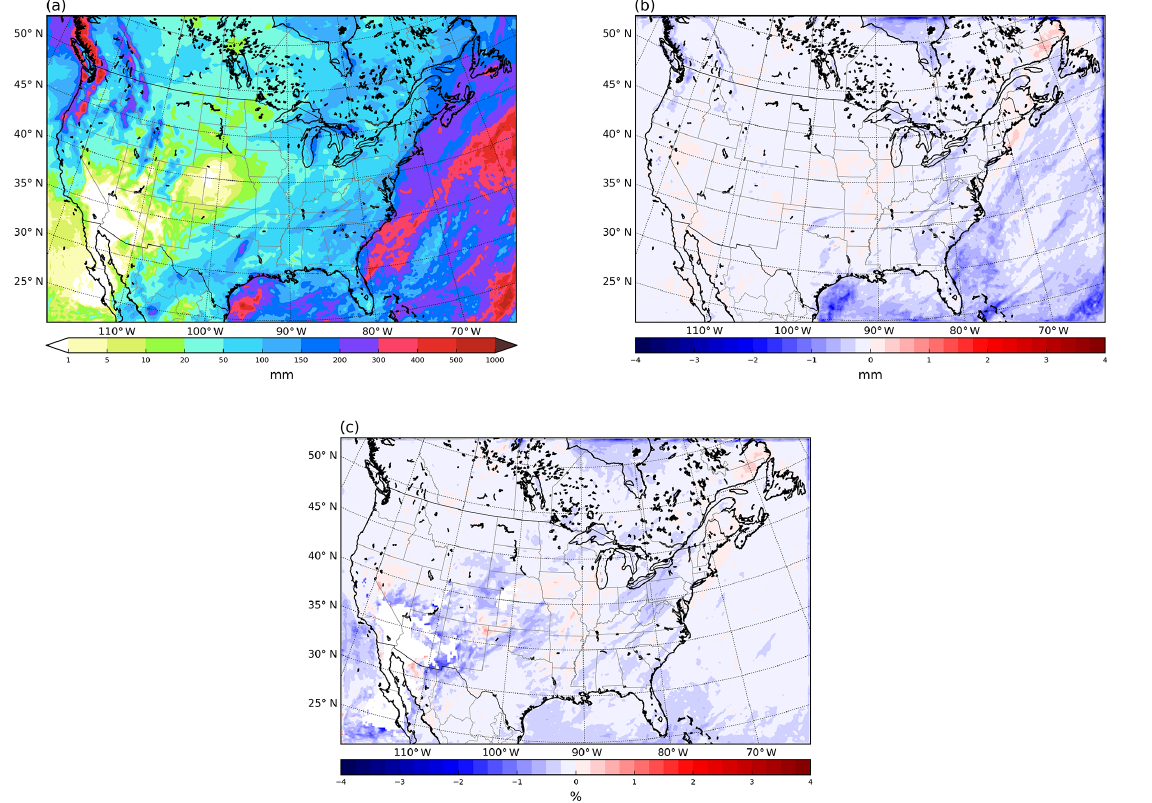
Figure 5. Total monthly accumulated model precipitation (mm) (a) , tracer precipitation absolute error (mm) (b) and tracer precipitation relative error (%) in areas where precipitation exceeds 1mm (c)